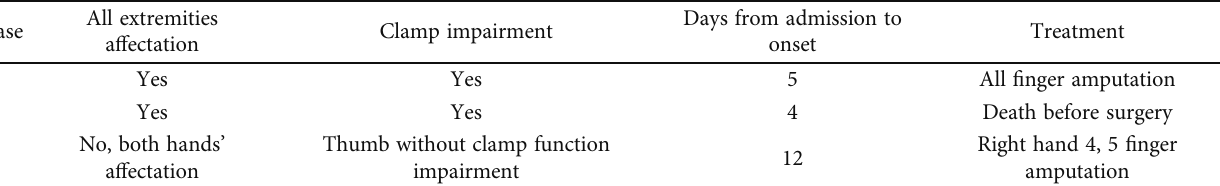
Table 2: Summary of clinical presentation and treatment of the three